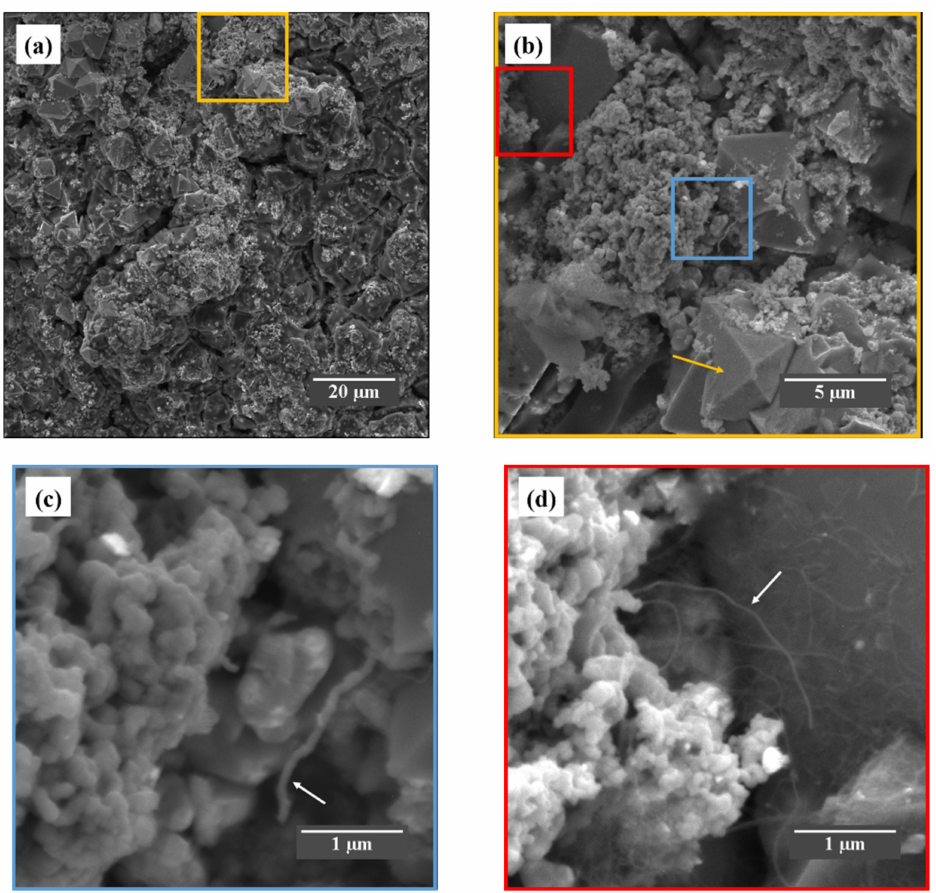
Figure 2. Al@Cu/f-CNT (1) wire morphology: ( a ) SEM micrograph at 2000 × magnification showing a predominantly homogeneously deposited coating. ( b ) 10,000 × magnification in the region of ( a ) highlighted in the yellow rectangle revealing pyramidal copper structures (yellow arrow). ( c ) 50,000 × magnification in the region of ( b ) highlighted in light blue rectangle. ( d ) 50,000 × magnifi- cation in the region of ( b ) highlighted in red rectangle. In ( c ) clustered copper crystals are observed coating f-CNT (white arrow), while in ( d ) f-CNT (white arrow) are found only on one of the prismatic faces of Cu.